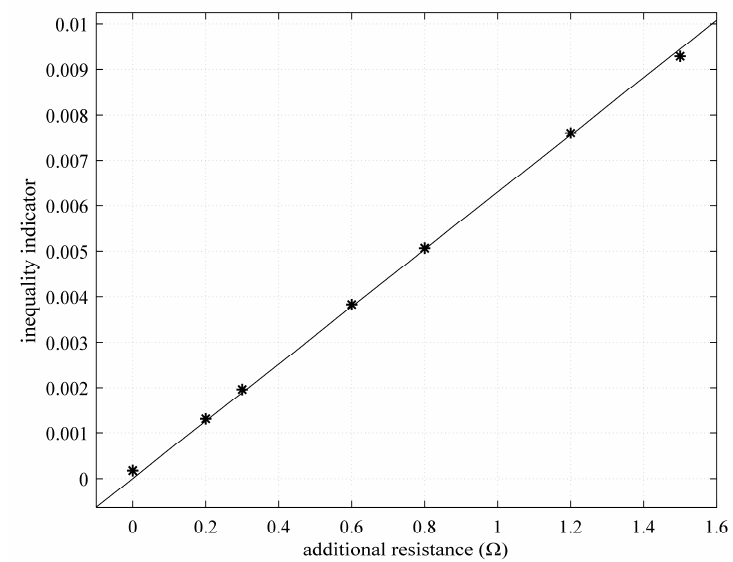
Figure 6. The relation between inequality indicator and additional resistance.